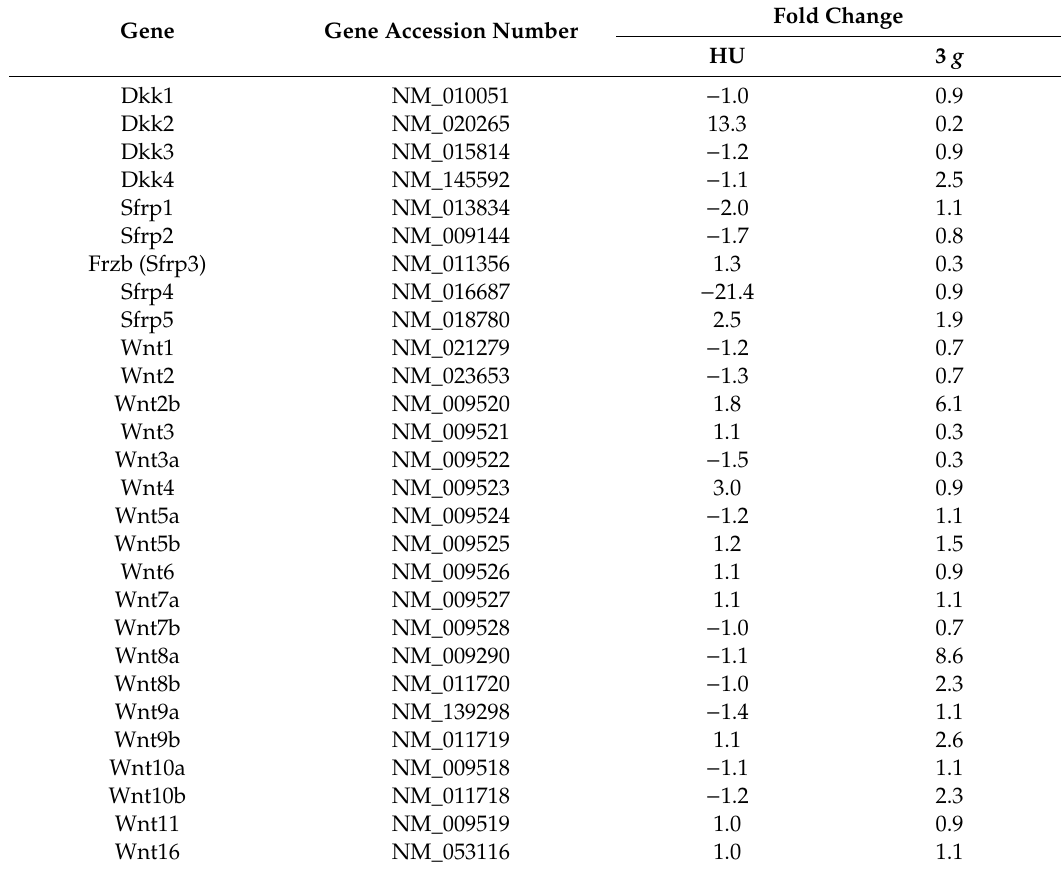
Table 2. Gene transcripts of Wnt signal-related factors in the soleus muscle of mice with HU versus control mice as well as 3 g mice versus 1 g